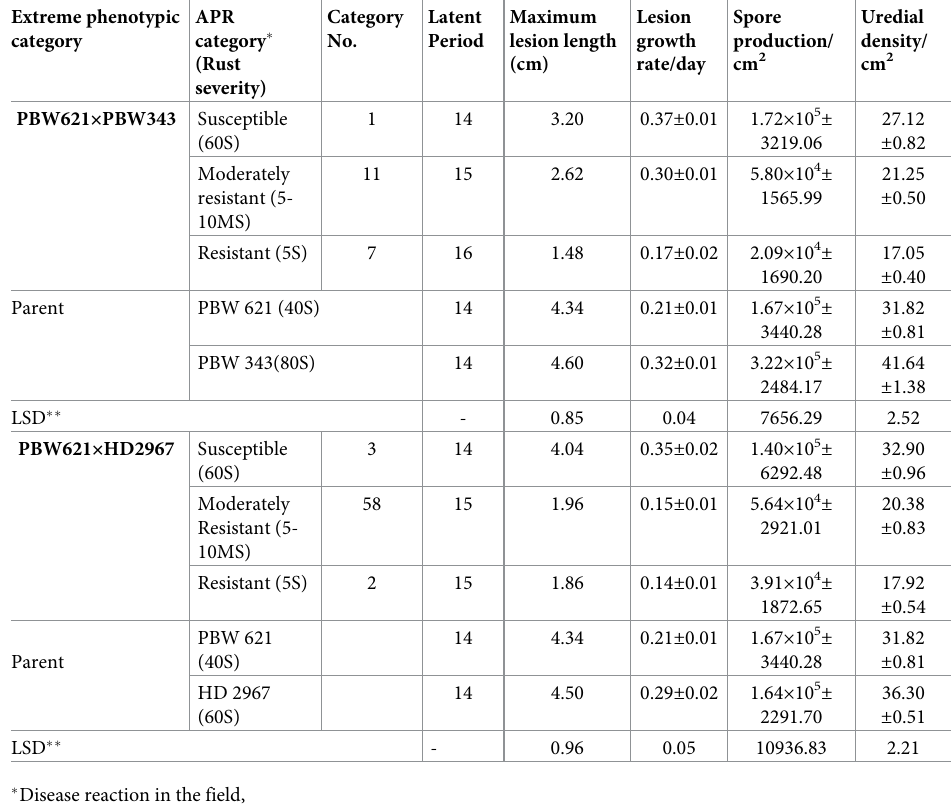
Table 3. Adult plant resistance components on selected extreme phenotypic categories from 2 crosses (PBW 621 X PBW 343 and PBW 621 X HD 2967). Extreme phenotypic APR category category � (Rust